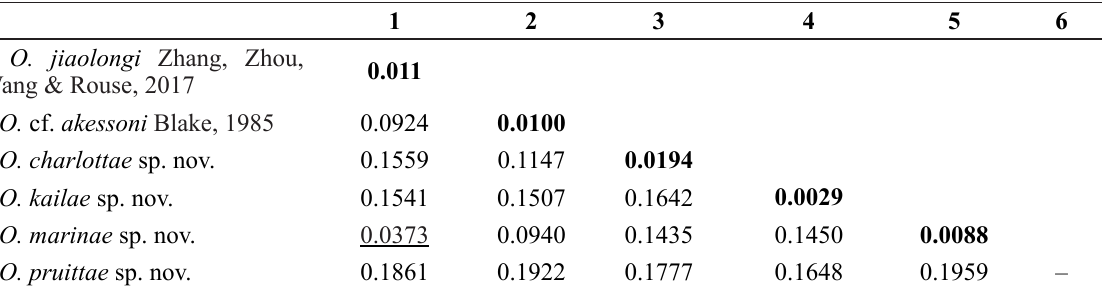
Table 2. Minimum pairwise distances of COI sequences using uncorrected p-distances for 3 eastern Pacific new vent species of Ophryotrocha Claparède & Mecznikow, 1869, O. cf. akessoni Blake, 1985 and the closely related vent species O. jiaolongi Zhang, Zhou, Wang & Rouse, 2017. Bold values represent maximum intraspecific variation when known. Values for O. jiaolongi based on GenBank data reported in Zhou et al. (2022). The smallest interspecific distance found was between O. jiaolongi (Indian Ocean vents) and O. marinae sp. nov. (Gulf of California vents) with a minimum distance of 3.73% (and a maximum of 5.2% (underlined)).